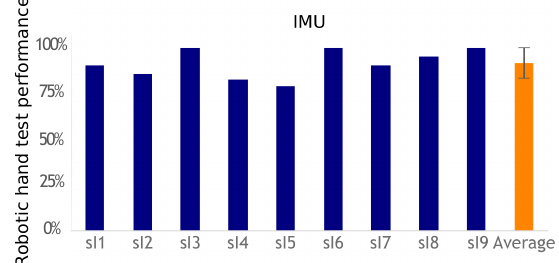
Figure 7. Performance results with the IMU